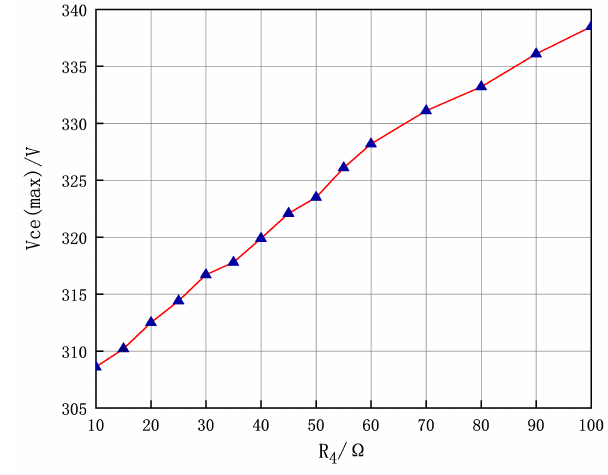
Figure 9. Curve of V ce ( max ) changing with R 4